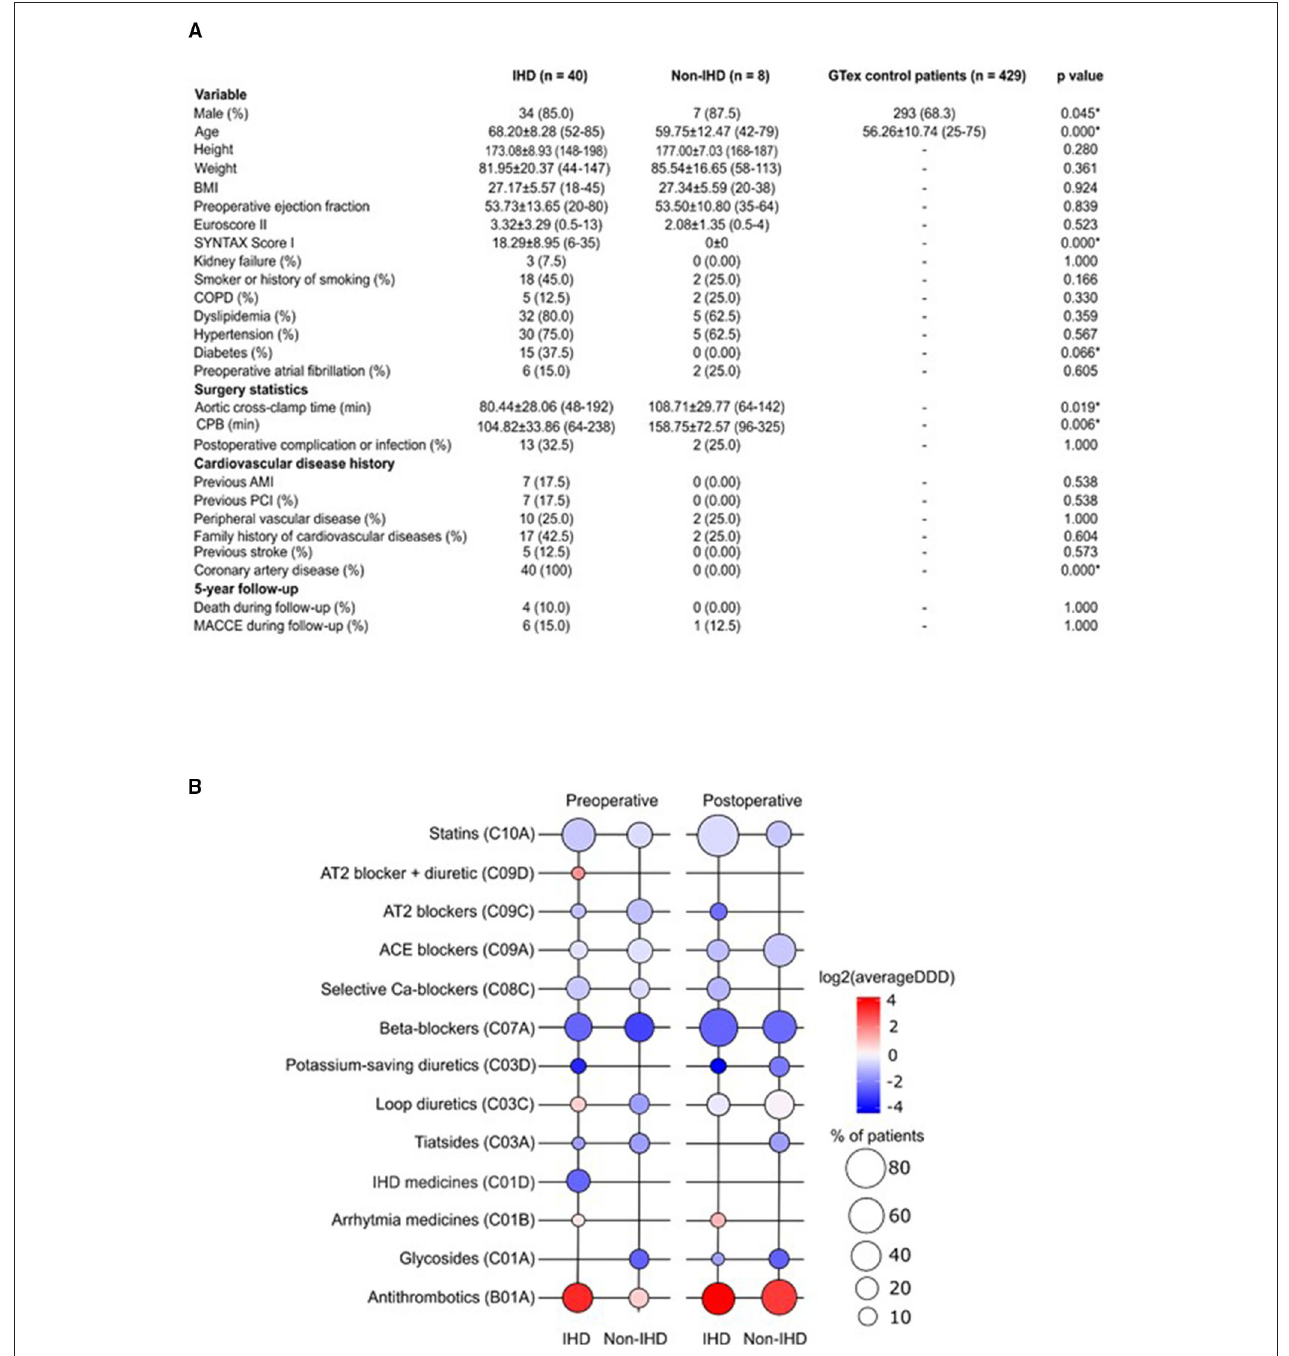
FIGURE 1 | (A) Demographic characteristics of the study population. AMI, acute myocardial infarction; BMI, body mass index; COPD, chronic obstructive pulmonary disease; CPB, cardiopulmonary bypass; MACCE, major adverse cardiovascular and cerebrovascular event; PCI, percutaneous coronary intervention. (B) Pre- and post-operative medication use in the study groups. Color key representing the total use of medication (as log 2 average DDD); bubble plot representing the percentage of patients on medication indicated in study groups. DDD, defined daily dose.